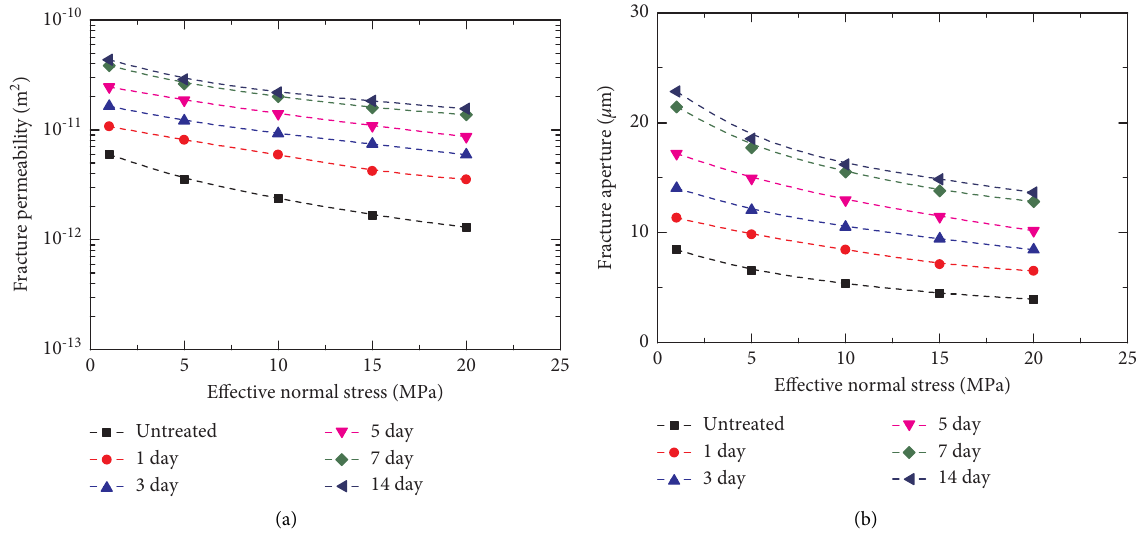
Figure 2: Permeability and hydraulic aperture evolution with effective normal stress for shale fractures after the Sc-CO permeability and (b) fracture hydraulic